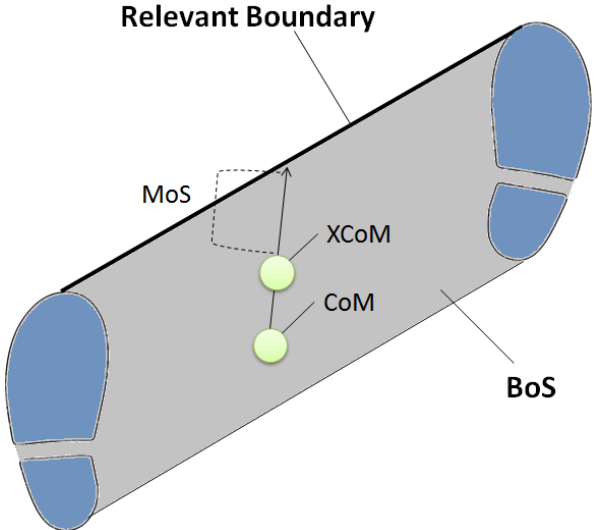
Figure 2. Description of balance in the transverse plane. MoS = margin of stability; BoS = base of support; CoM = centre of mass; XCoM = extrapolated centre of pass; Relevant boundary depending on the direction of CoM movement.